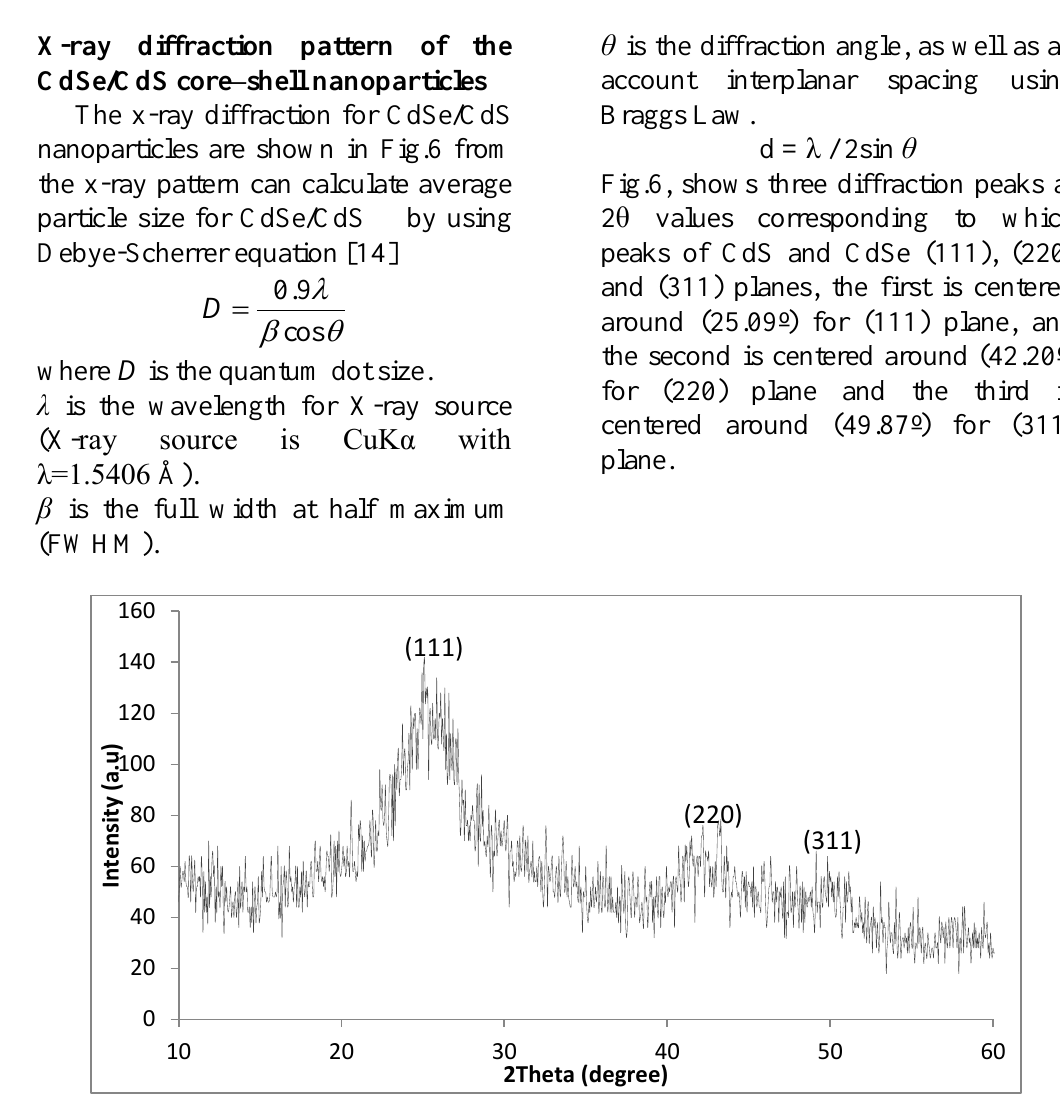
Fig.6: The XRD pattern of the CdSe/CdS core-shell